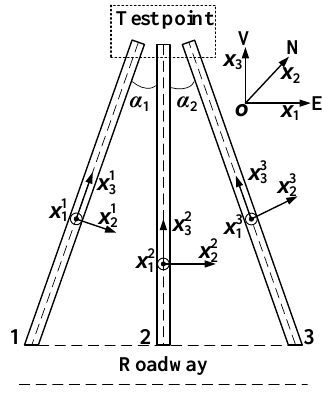
Figure 2. Three boreholes and local coordinate systems.